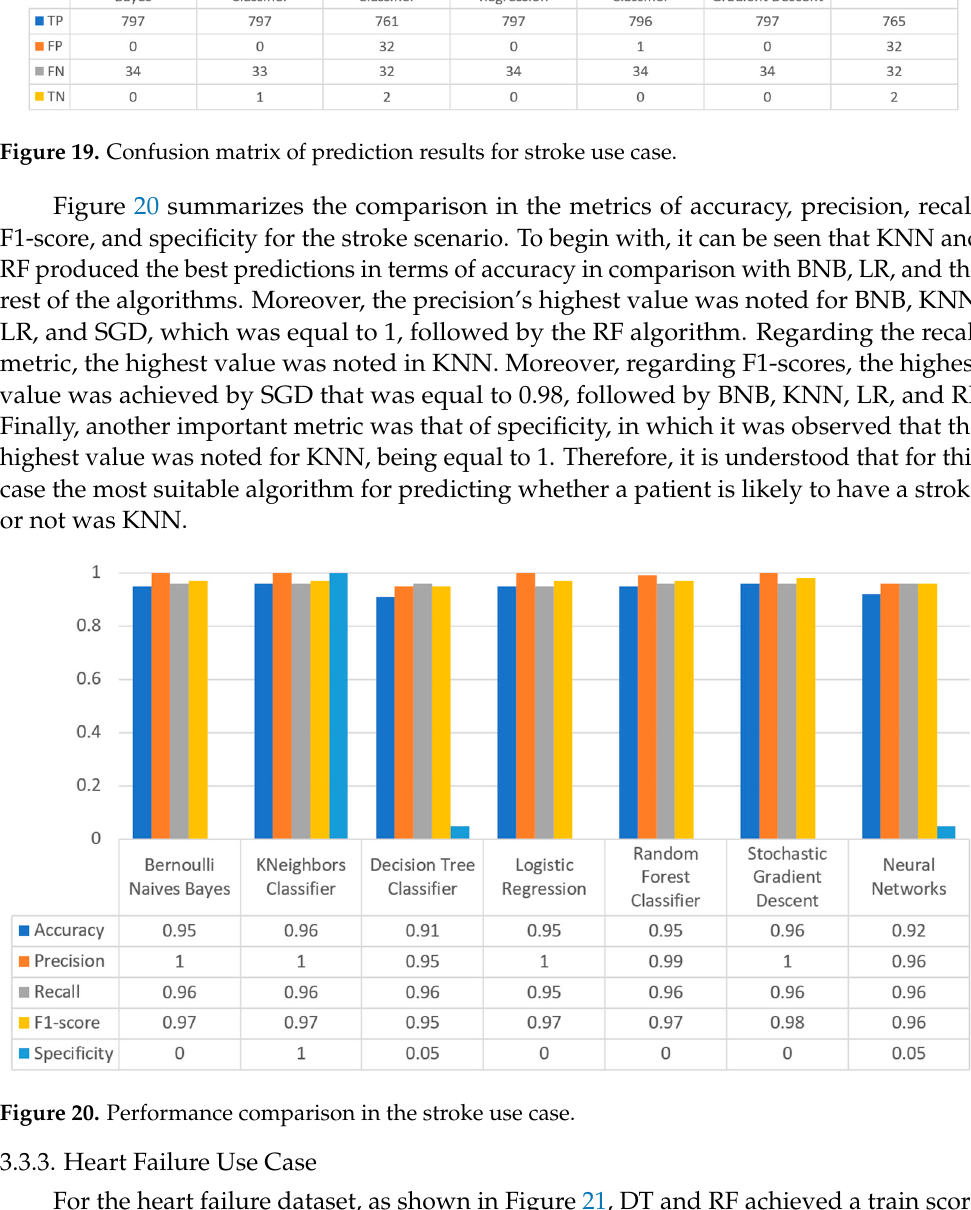
Figure 19. Confusion matrix of prediction results for stroke use case.